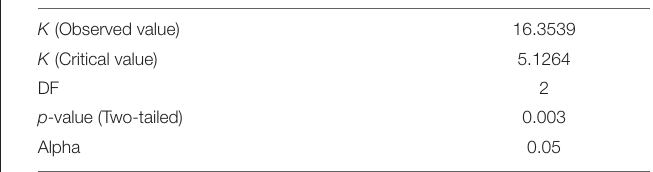
TABLE 7 | Results of Kruskal-Wallis